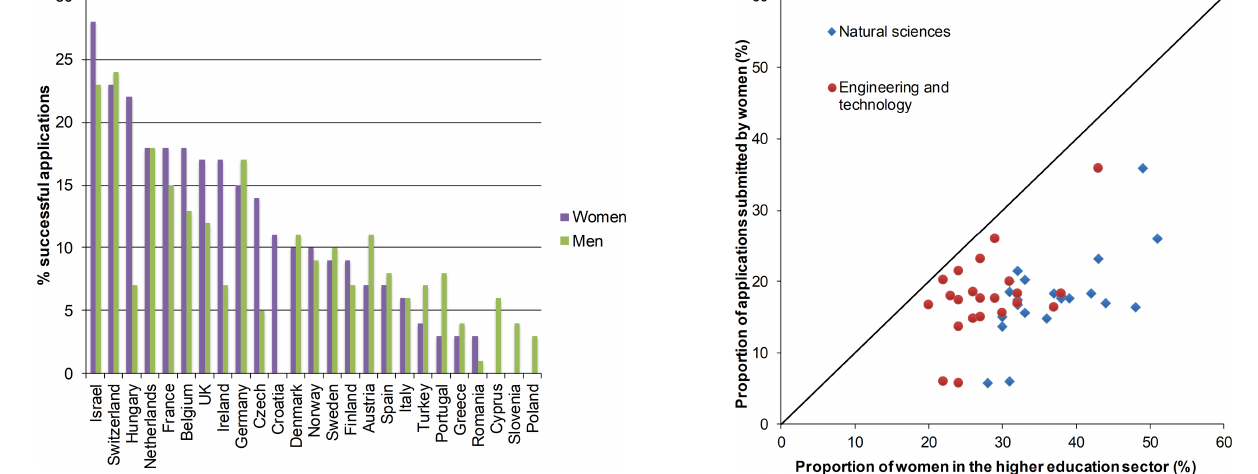
Figure 3. Proportion of women among researchers in the higher ed- ucation sector (%) in Natural Sciences (blue diamonds) and Engi- neering and Technology (red circles) (source: Table 4.2 in European Commission, She Figures 2018) and the proportion of applications submitted by women to the ERC 2012–2018 in the PE panels. Each point represents one country. The black line indicates the 1 : 1 line with an equal proportion of applications submitted by women and proportion of women in the higher education sector. Table 1. Distribution of the final scores on all applications submit- ted to the ERC 2012–2018 in the PE panels in number of applica- tions and the proportion of applications with that particular grade per